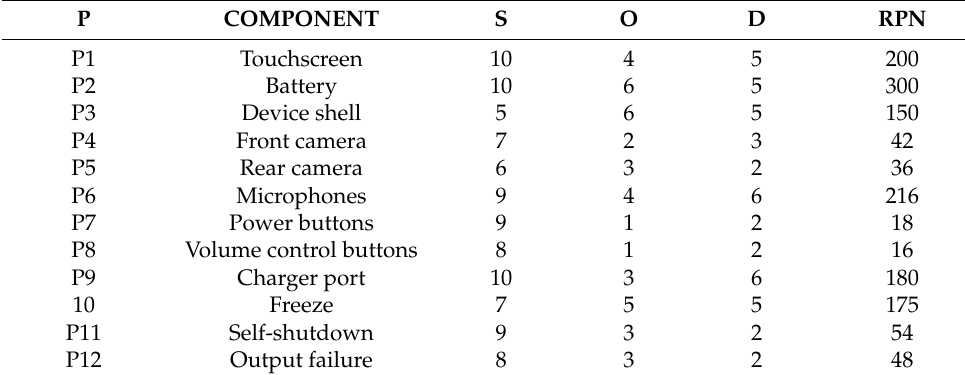
Table 3. Collection of S, O, D, and RPN values from the 2nd team.